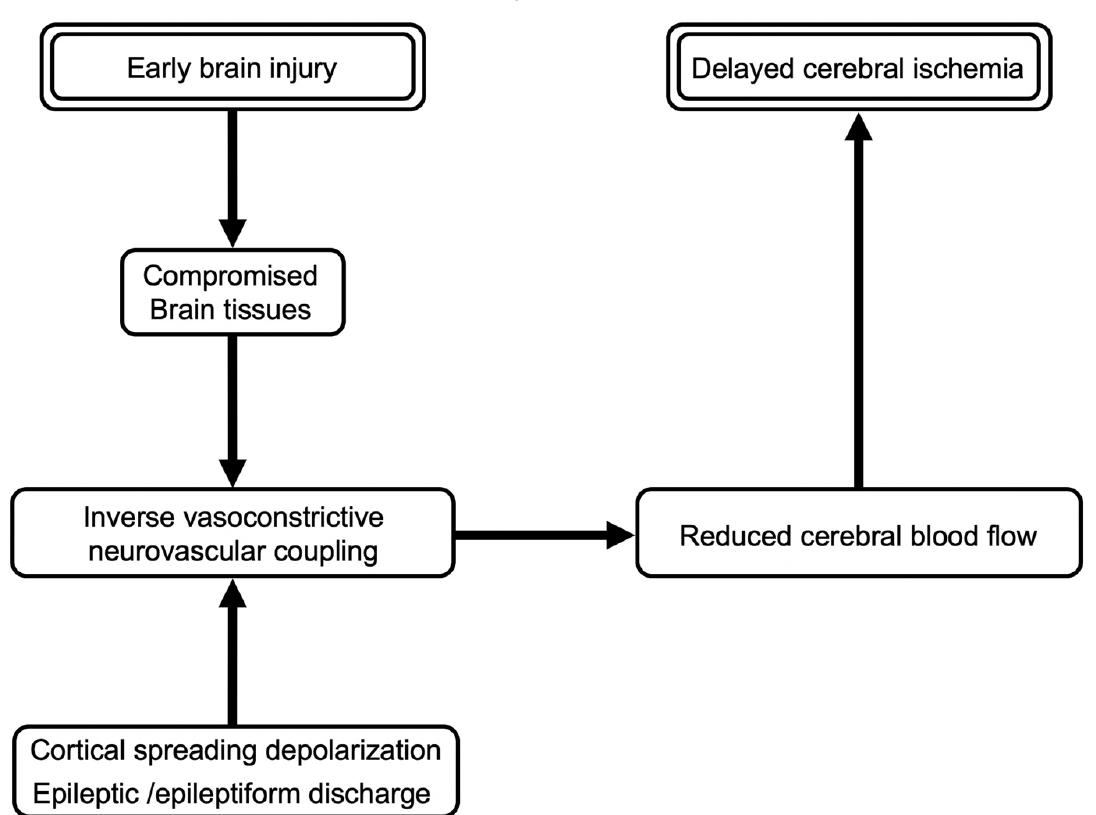
Figure 4. A mechanism for cortical spreading depolarization or epileptiform discharges to cause delayed cerebral ischemia. In the compromised brain after subarachnoid hemorrhage, the neuroelectric disruption increases metabolic demand but decreases cerebral blood flow through inverse vasoconstrictive neurovascular coupling, leading to DCI.